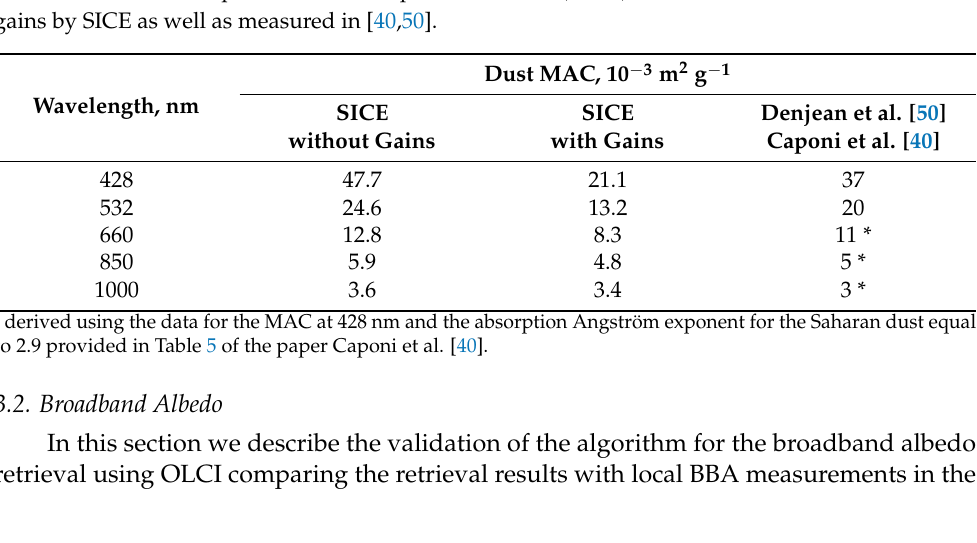
* derived using the data for the MAC at 428 nm and the absorption Angström exponent for the Saharan dust equal to 2.9 provided in Table 5 of the paper Caponi et al. [41].